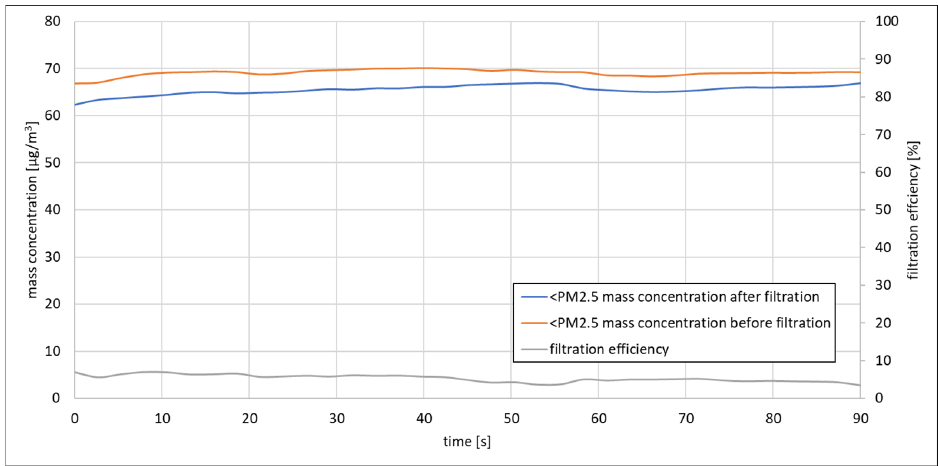
Figure 4. Mass concentration of ≤ PM 2.5 size before and after anti ‐ smog fabric cover regarding filtration efficiency (temperature: 11 °C, relative humidity: 50%).